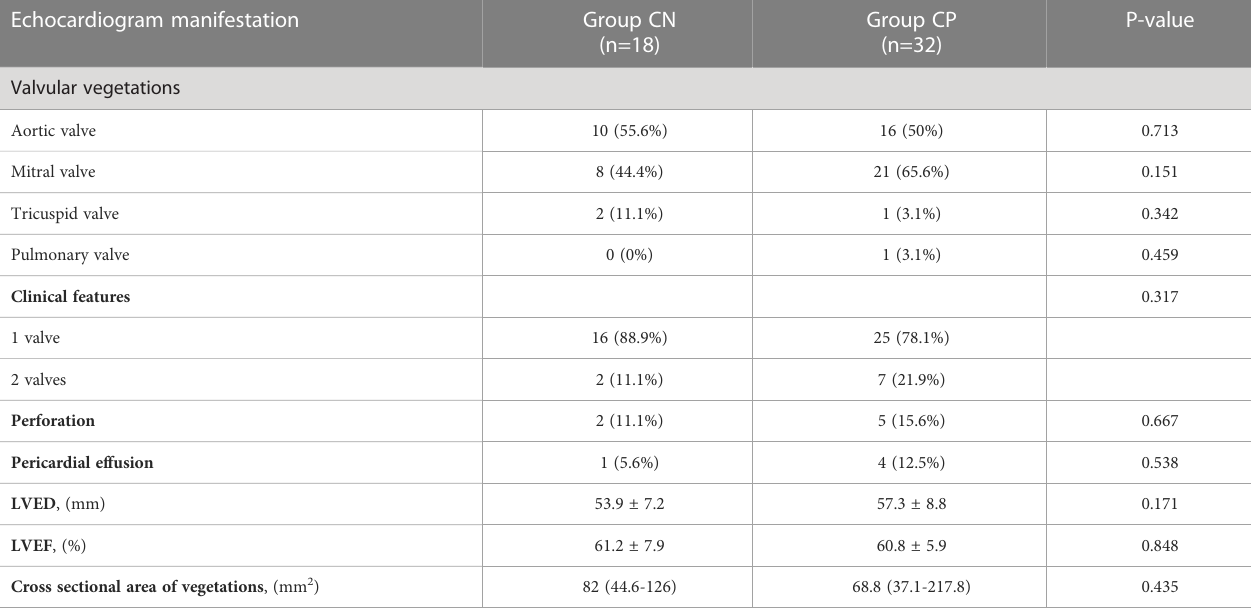
TABLE 3 Echocardiogram manifestations of the culture-negative IE and culture-positive IE patients. Echocardiogram manifestation